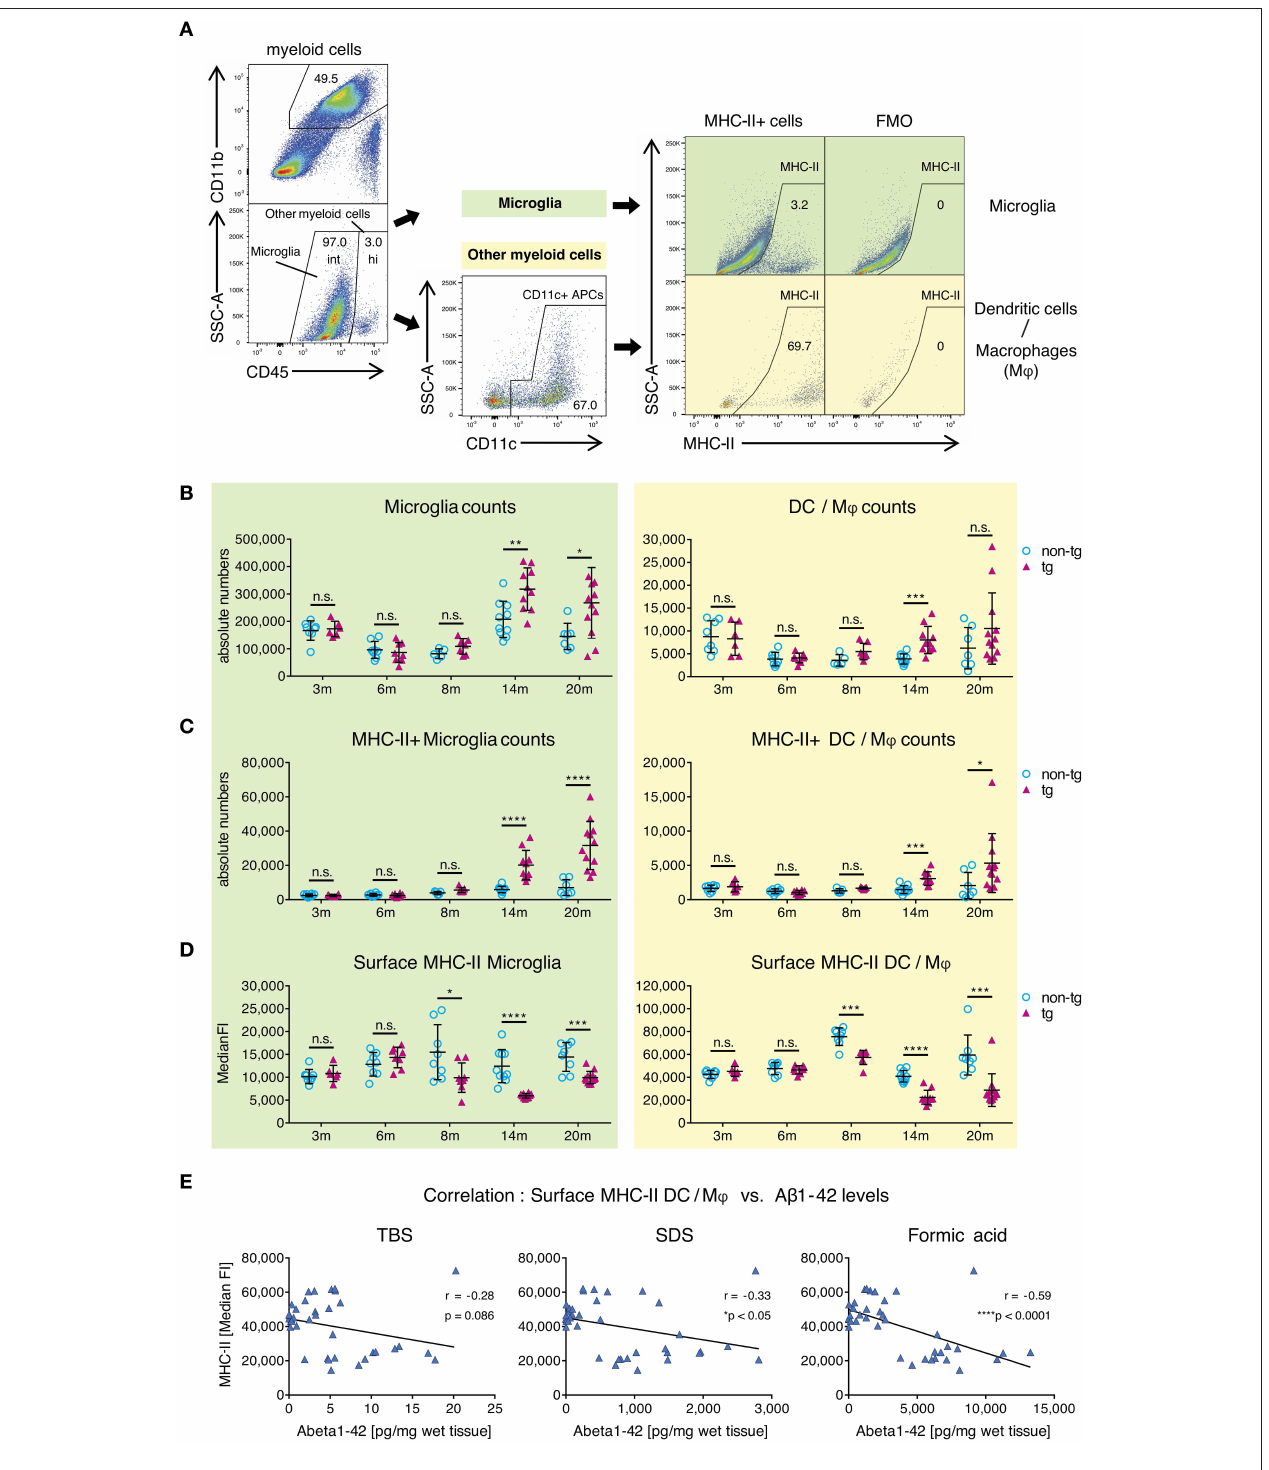
FIGURE 2 | Alterations in MHC class II surface expression on APCs in brains of APP-PS1 transgenic mice. (A) Schematic of flow cytometry analysis of cerebral APCs. Myeloid cells (CD45 + , CD11b + ) are gated based on CD45 levels to distinguish “microglia” (CD45 intermediate, int) and “other myeloid cells” (CD45 high, hi). Dendritic cells (DC) and CNS border-associated macrophages (M ϕ ) are gated from “other myeloid cells” based on CD11c expression ( = DC/M ϕ ). FMO = fluorescence minus one control. Numbers in gates indicate percent cells of parental gate. (B) Absolute numbers of microglia and DC/M ϕ are elevated in brains of APP-PS1 tg mice at established plaque pathology stages (14 and 20 months of age) compared to non-tg, age-matched animals. (C) Analysis of surface MHC class II (MHC-II) expression